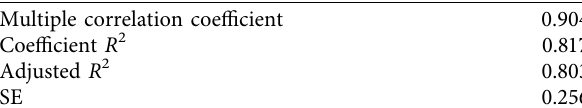
Table 5: Statistics for regression model 02.